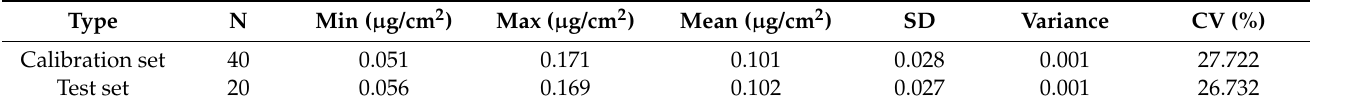
Table 1. Statistical analysis of calibration-set Anth and test-set Anth.